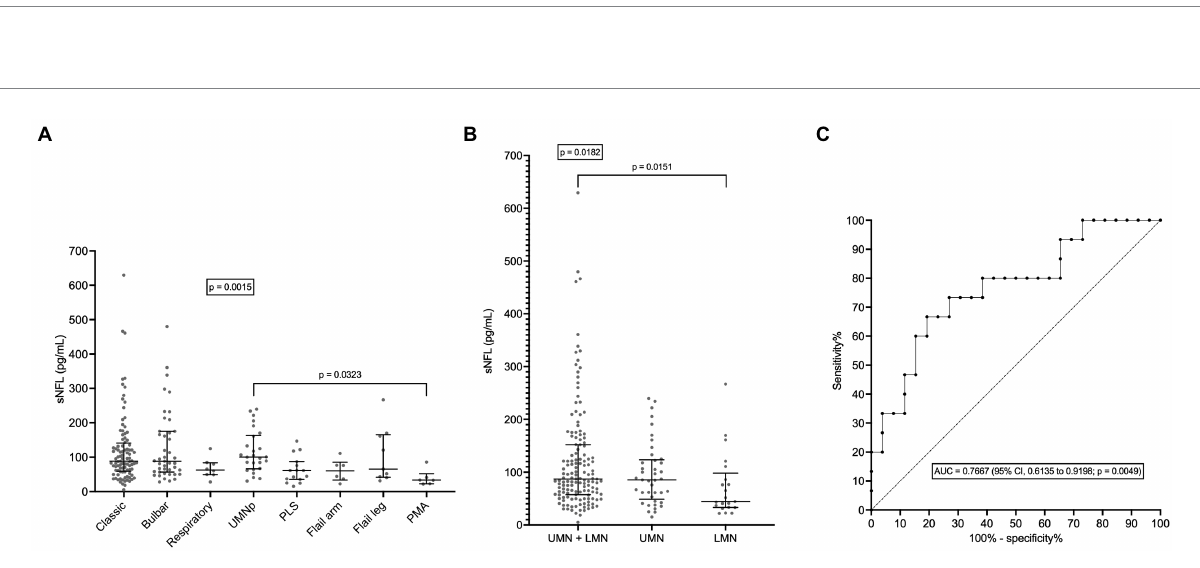
FIGURE 2 Serum NFL levels in different ALS motor phenotypes. (A) sNFL levels in all individual motor phenotypes of ALS. (B) sNFL levels in the three grouped ALS motor phenotypes according to UMN or LMN impairment. (C) ROC curve for the discrimination between PLS and UMNp ALS. In (A,B) wide horizontal bars represent median values, narrower horizontal bars represent first and third quartiles. AUC, area under the curve; CI, confidence interval; LMN, lower motor neuron; NFL, neurofilament light chain; PLS, primary lateral sclerosis; PMA, progressive muscular atrophy; ROC, receiver operating characteristic; sNFL, serum neurofilament light chain; UMN, upper motor neuron; UMNp, upper-motor-neuron-predominant ALS.